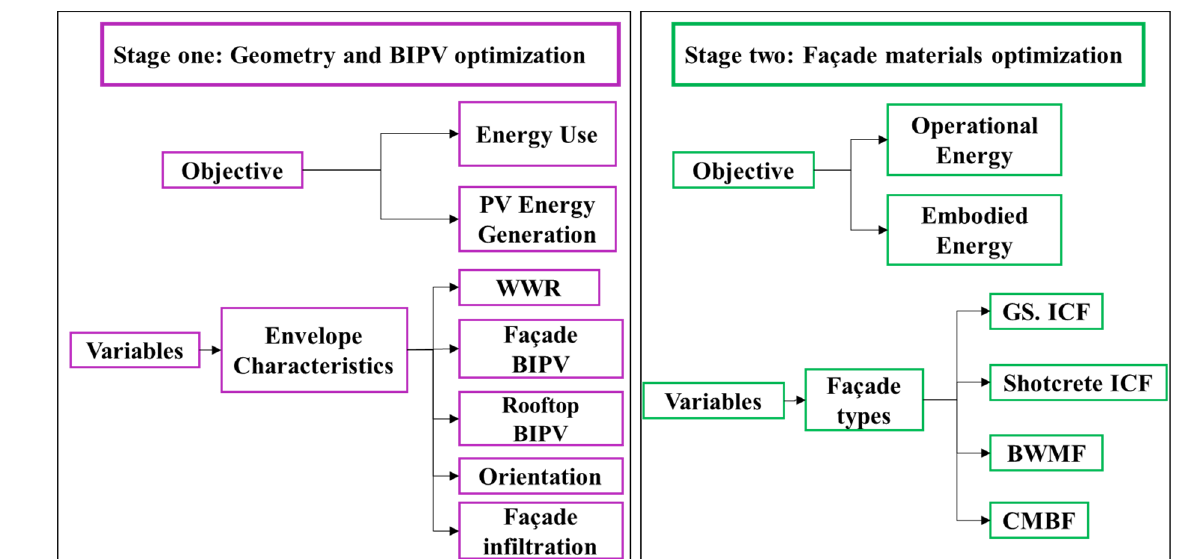
Figure 5. Illustration of passive and active parameters two-stage optimization